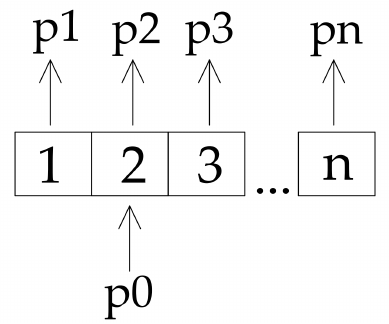
Figure 2. N-section